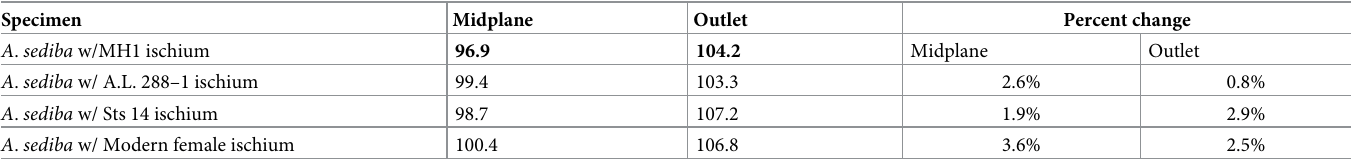
Table 2. Composite A . sediba pelvic measures.